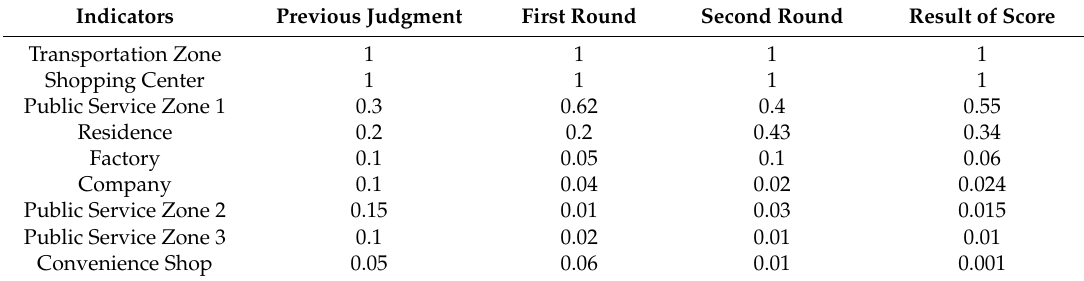
Table 2. The weights of the segmenting function with a range from 1 to 9: first and second round. Indicators Previous Judgment First Round Second Round Result of